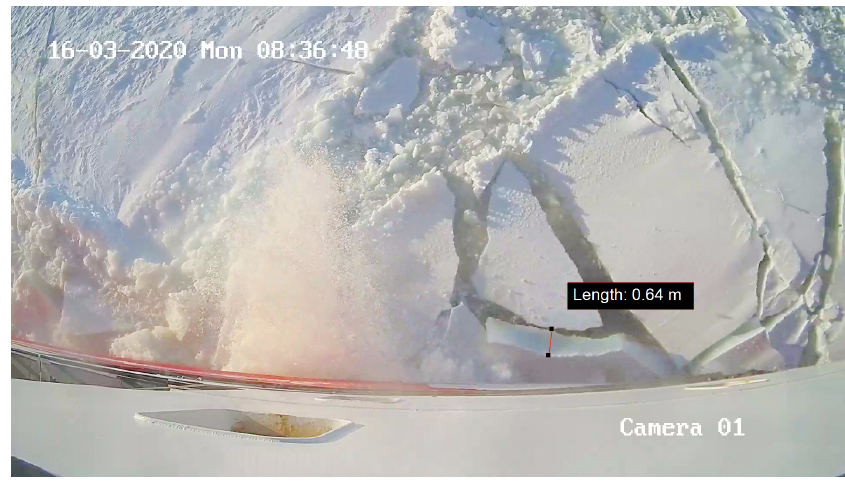
Figure 20. Ice conditions characterizing the time interval of the dataset from Figure 19.